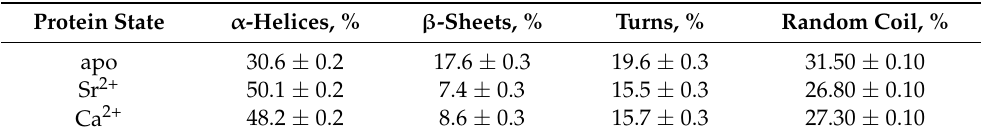
Table 2. The secondary structure fractions estimated for rWT α -PA at 20 ◦ C from the CD data shown in Figure 6, using CDPro software